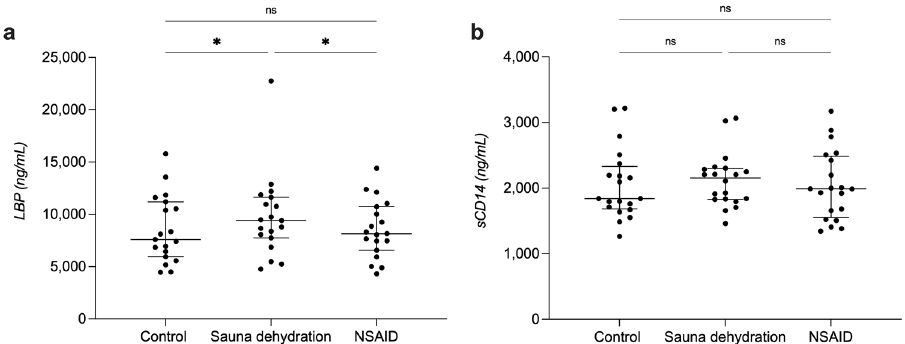
Figure 3. Lipopolysaccharide-binding protein and soluble CD14 concentrations at the different test conditions. ( a ) Plasma concentrations of lipopolysaccharide-binding protein (LBP). ( b ) Plasma concentrations of soluble CD14 (sCD14). The horizontal line marks the median, the vertical line spans through the interquartile range (IQR). The dots represent the individuals. * P < 0.05. ns, non-significant. NSAID, nonsteroidal anti- inflammatory drug. Data of one participant was excluded from the LBP analysis due to disproportionately high baseline